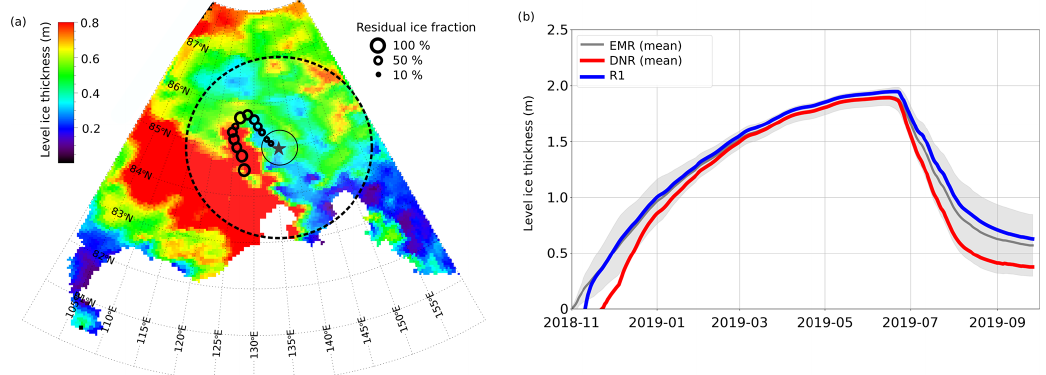
Figure 5. (a) Level ice thickness on 25 September 2019 simulated with a thermodynamic model (see Methods). The percentage of residual ice observed along the course of Akademik Fedorov (black circles) is superimposed. (b) Growth and melt of level ice in the EMR, DNR and at R1 (cf. Fig.